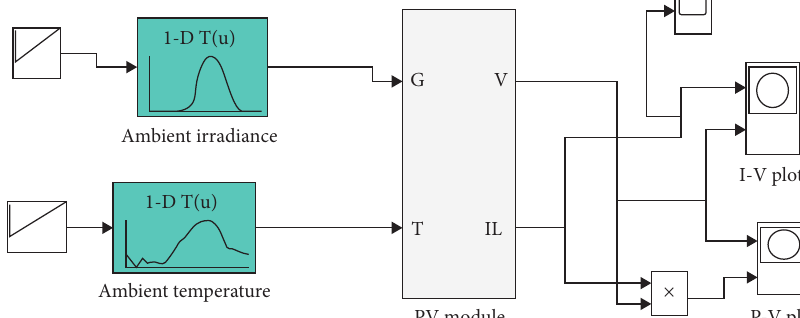
Figure 23: Modelled and implemented PV module node: block diagram.